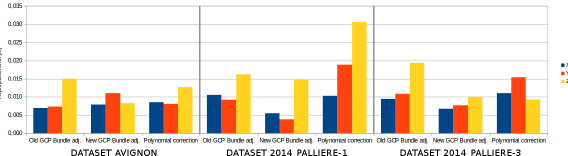
Figure 7: Comparison between three adjustment on GCP methods proposed : automatic (left) bundle adjustment with GCP, manual bundle adjustment with GPC, estimation of a polynomial